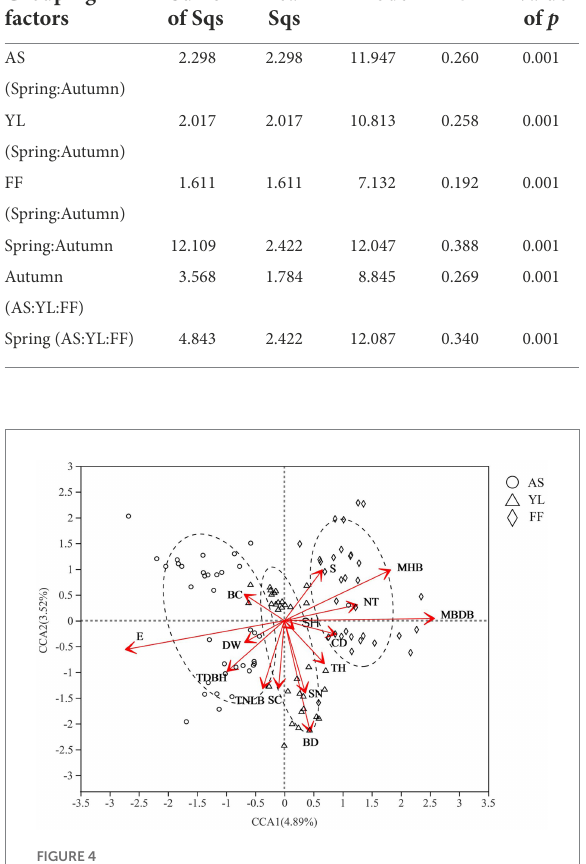
TABLE 1 PERMANOVA exploring the effects of three bamboo species and two seasons based on Bray–Curtis distance matrixes. Grouping factors